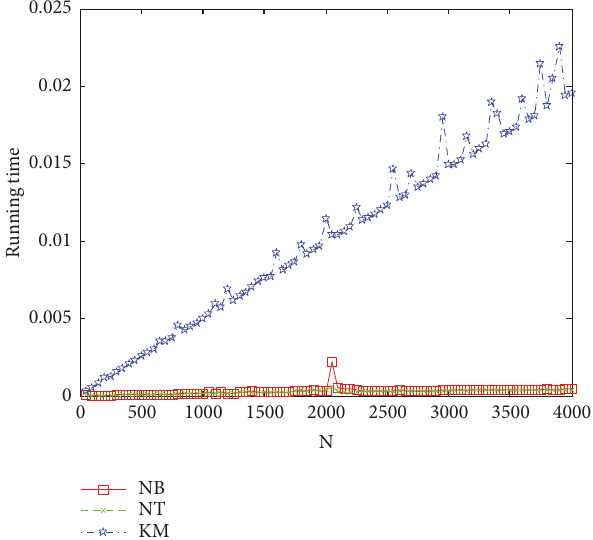
Figure 9: Computation time comparisons of example three.